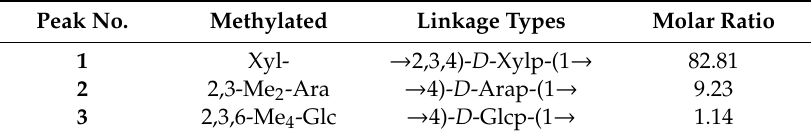
Table 2. Chemical shifts of glycosyl 1 H and 13 C in AX-I-3b.